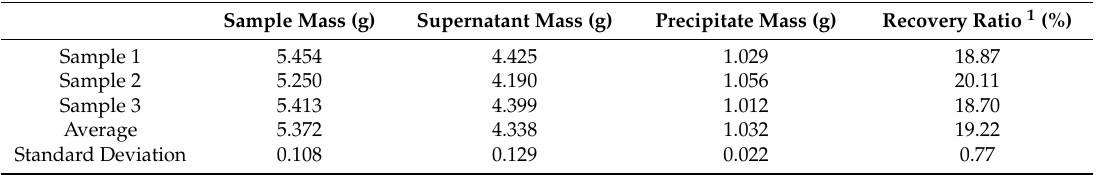
Table 3. Mass of oral suspension, separated supernatant and recovered precipitate as well as the recovery ratio of the precipitate after centrifugation of the Posaconazole oral suspension in